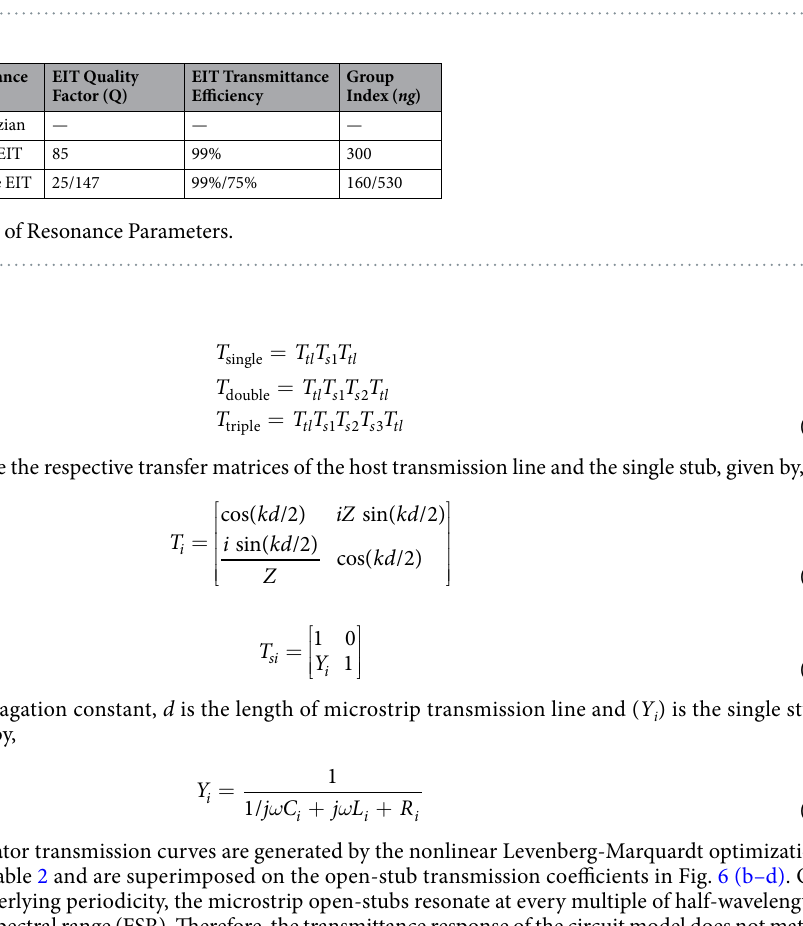
Figure 5. Experimental demonstration the tunability of EIT showing the Transmission Amplitude and Phase responses.